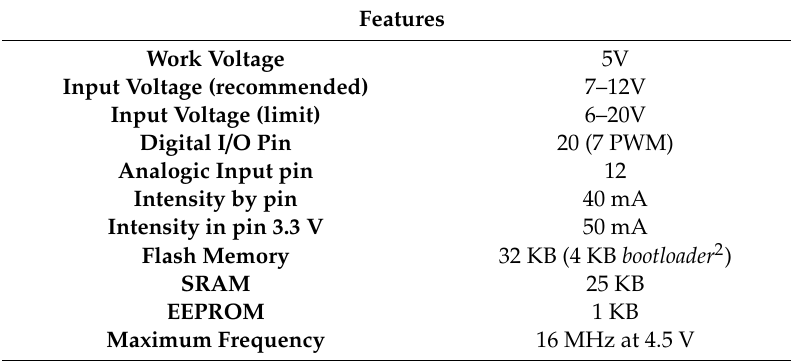
Table 3. Atmega32u4 technical